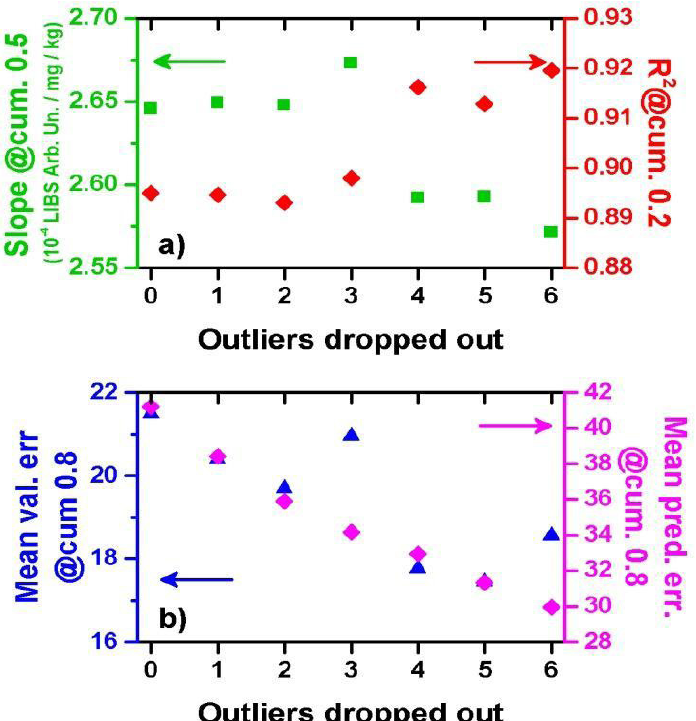
Fig. 6 Analysis of the outlier’s effect on the four main statistical indicators. a) Left (right) axis: values of the slope (R 2 ) for which the cumulative function is 0.5 (0.2). b) Left (right) axis: mean validation (prediction) error for which the cumulative function is